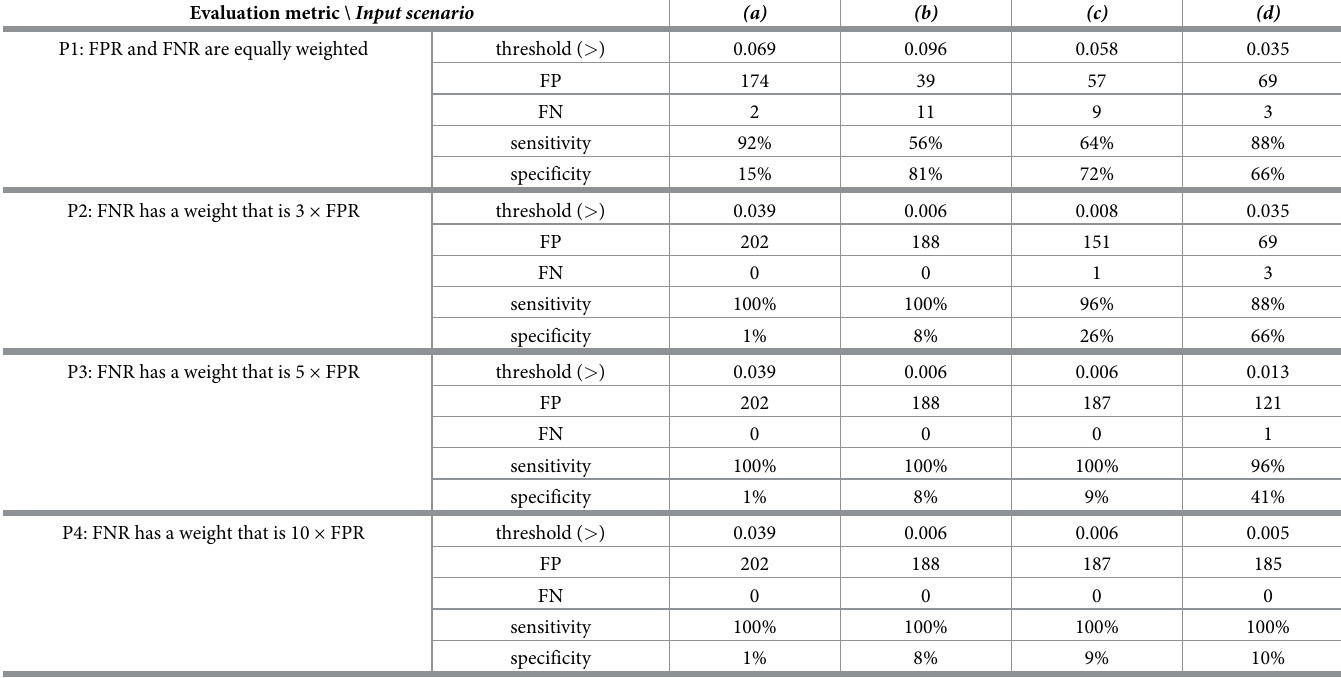
We varied relevant parameters by 20% to investigate how various factors affect the pre- dicted probability of typical bacterial pneumonia (24) which is determininistically related to the bacterial state of the causative pathogen for pneumonia (25) (Fig 8). Three groups of vari- ables were investigated, and the target prediction is most sensitive to parameters describing the pathogenicity of the potential pathogens in causing pneumonia (white), ranging from 12% to 50%. Varying the prevalence of various pathogens in the nasopharynx caused the predicted probability of the involvement of typical bacteria to vary from 22% to 30% (yellow). Varying Table 2. The optimal performance of the BN in predicting clinically-confirmed bacterial pneumonia (28) under different input scenarios and different FPR/FNR trade-off preferences (P1-P4). Specifically, we defined optimal based on a minimised weighted sum of FPR and FNR across the 10-fold cross-validation results. For each input scenario and FPR/FNR trade-off preference, we present here the threshold used when the optimal performance is achieved, and its associated false positives (FP), false negatives (FN), sensitivity and specificity. Note that there is a total of 25 positive observations of clinically-confirmed bacterial pneumonia in our cohort of 230 cases of X-ray confirmed pneumonia. Raw results and scripts for generating these metrics can be accessed via Open Science Framework